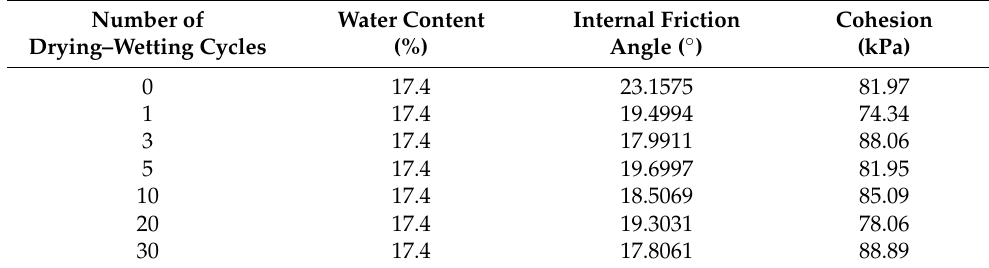
Table 5. Shear strength parameters.